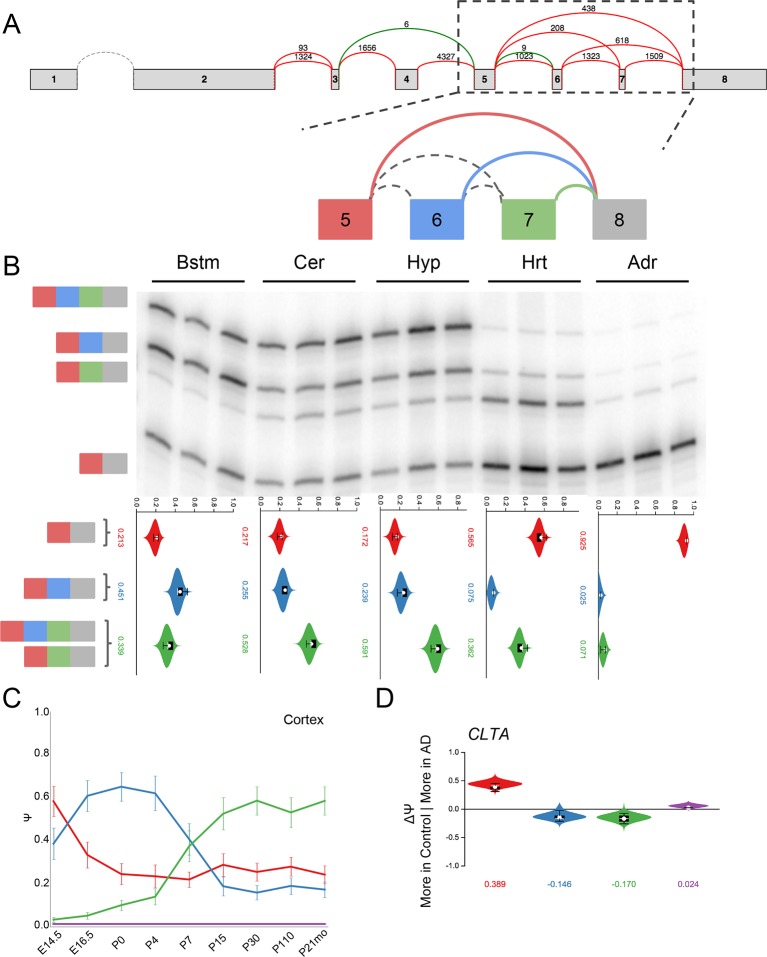
Clta splicing is developmentally regulated and dysregulated in
Alzheimer’s Disease.(A) Splice graph for Clta and
representation of target LSV. (B) Top panel: RT-PCR
validation with RNA from replicate tissues with isoforms illustrated on
the left. Bottom panel: PSI violin plots of MAJIQ quantification of
junctions as colored in (A). (C) Line graphs of
MAJIQ Ψ quantification (y-axis) of junctions as in (A)
across time points (x-axis) through cortex development. Points represent
mean Ψ and error bars represent one standard deviation. (D)
ΔΨ quantification comparing changes between control and Alzheimer’s
patient brains of the homologous junctions illustrated in
(A).